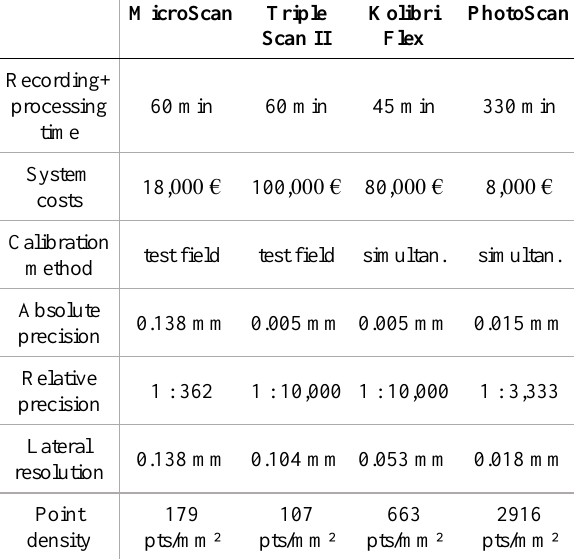
Table 1. Comparison of data acquisition methods